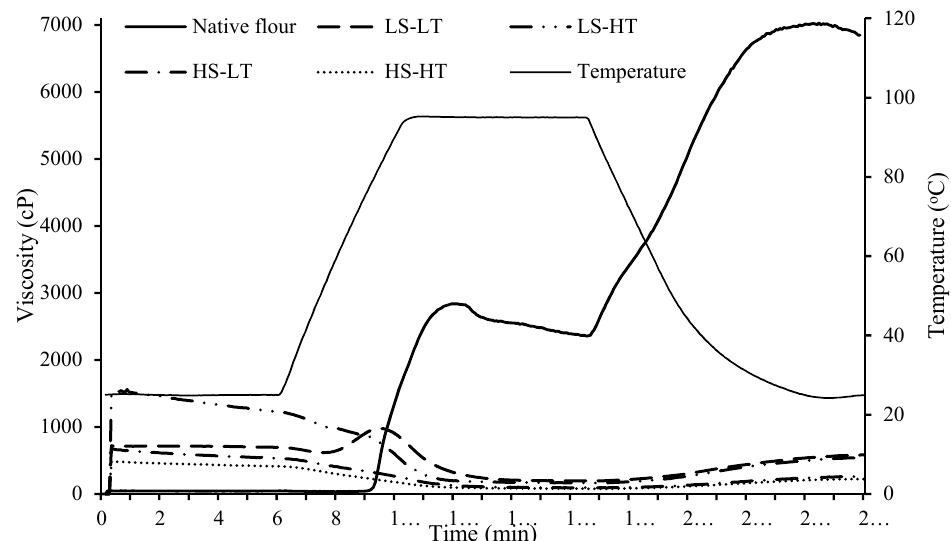
Figure 1. Pasting profile of native and extruded breadfruit flours. Treatments include native breadfruit flour and four extruded breadfruit flours: LS-LT: specific mechanical energy (SME) = 74 kJ/kg, melt temperature = 83 °C; LS-HT: SME = 74 kJ/kg, melt temperature = 105 °C; HS-LT: SME = 145 kJ/kg, melt